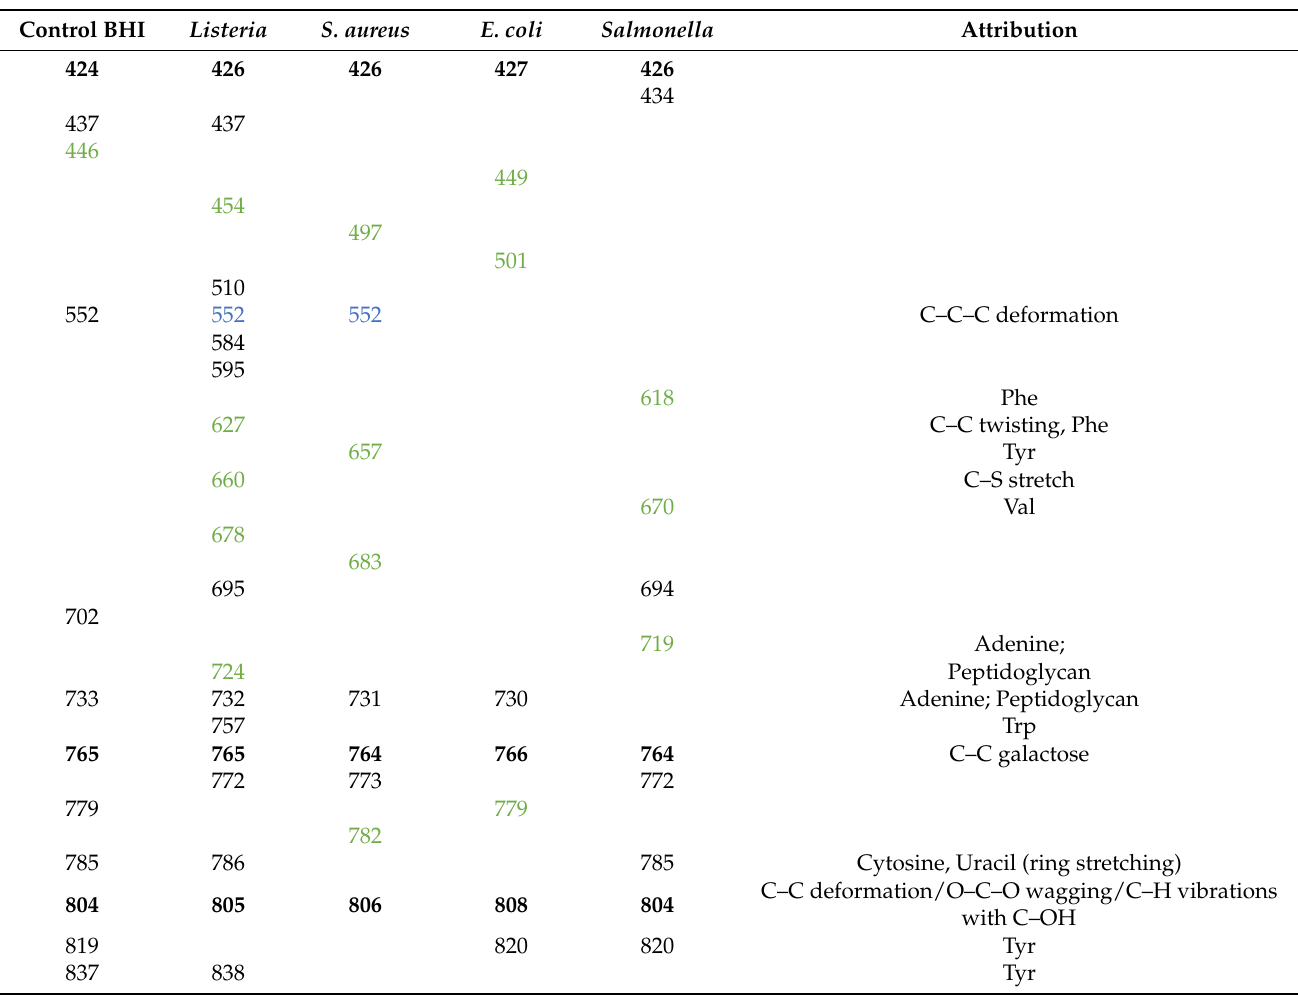
Table 2. Peak positions and tentative attributions for Raman spectra of control media broth BHI, Listeria , S. aureus , E. coli , and Salmonella based on similar studies [25,29–35]. Distinctive peaks for each strain or control are coloured in green, peaks matching Gram-positive are coloured in blue, Gram-negative are coloured in red, and bolded signals match with all the samples, including